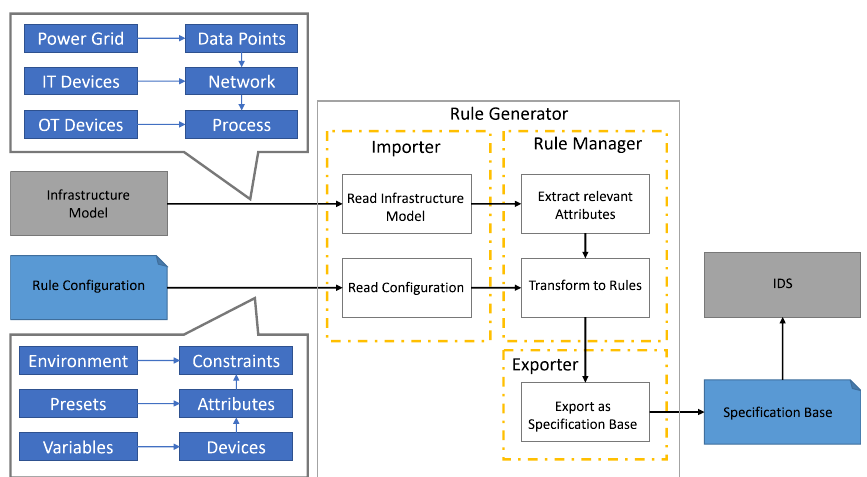
Fig. 3 Illustration of the rule generation process to automatically generate the SB based on the infrastructure model